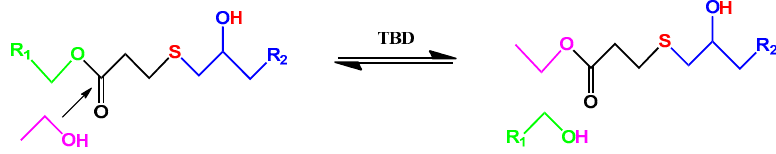
Figure 7. ( a ) AFM images of the surface, and SEM images of the fracture surface, ( b ) before and ( c , d ) after healing for the TO/TMMP-TMTGE self-healing composite. Figure 8. SEM images of the fracture surface ( a ) before and ( b ) after healing for the TMMP-TMTGE self-healing material. Figure 9. AFM images of scratch after healing for the ( a ) TMMP-TMTGE self-healing material and ( b ) TO/TMMP-TMTGE self-healing composite.